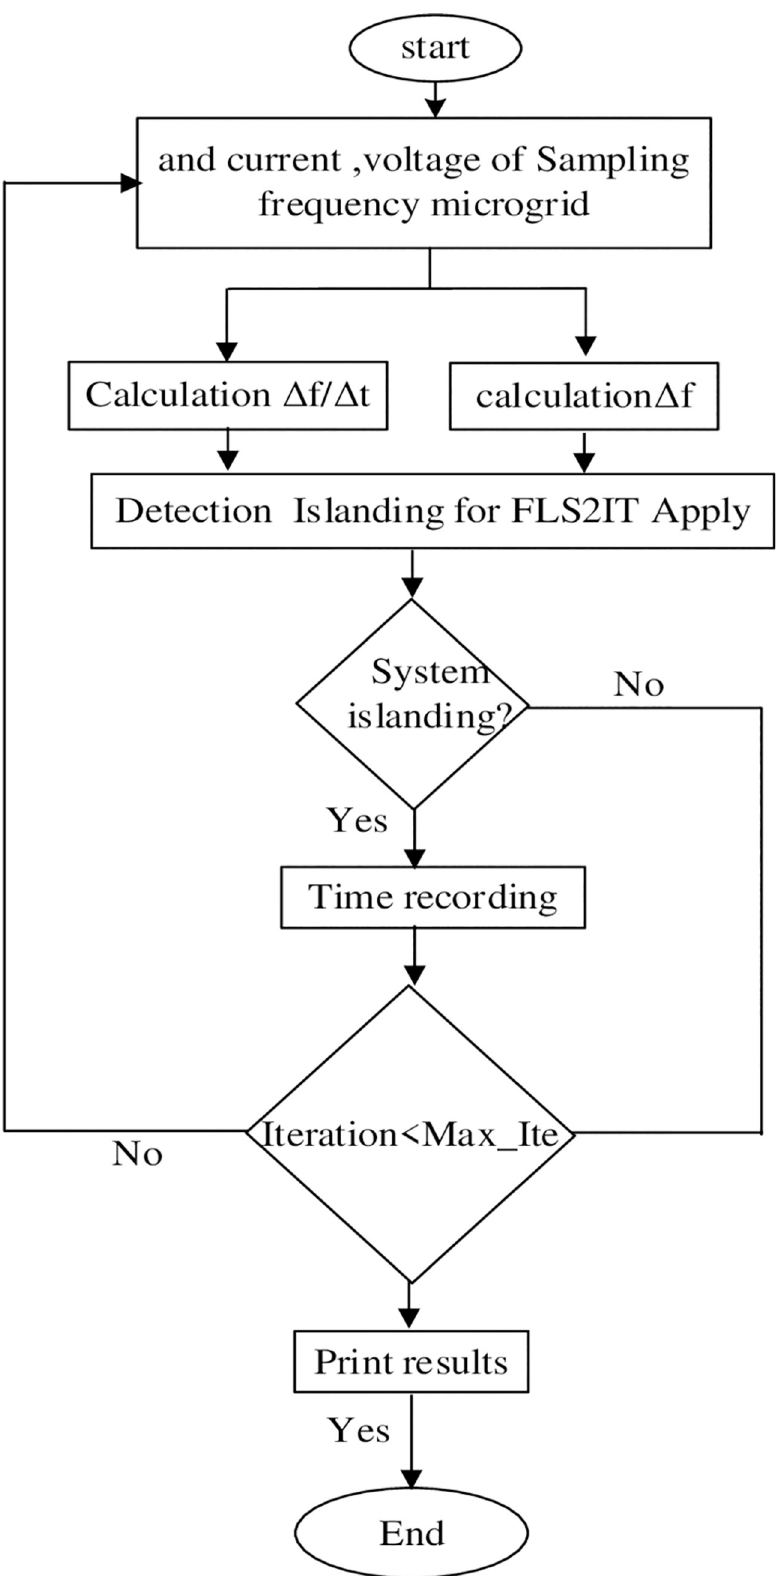
Fig 5. Flowchart of the proposed